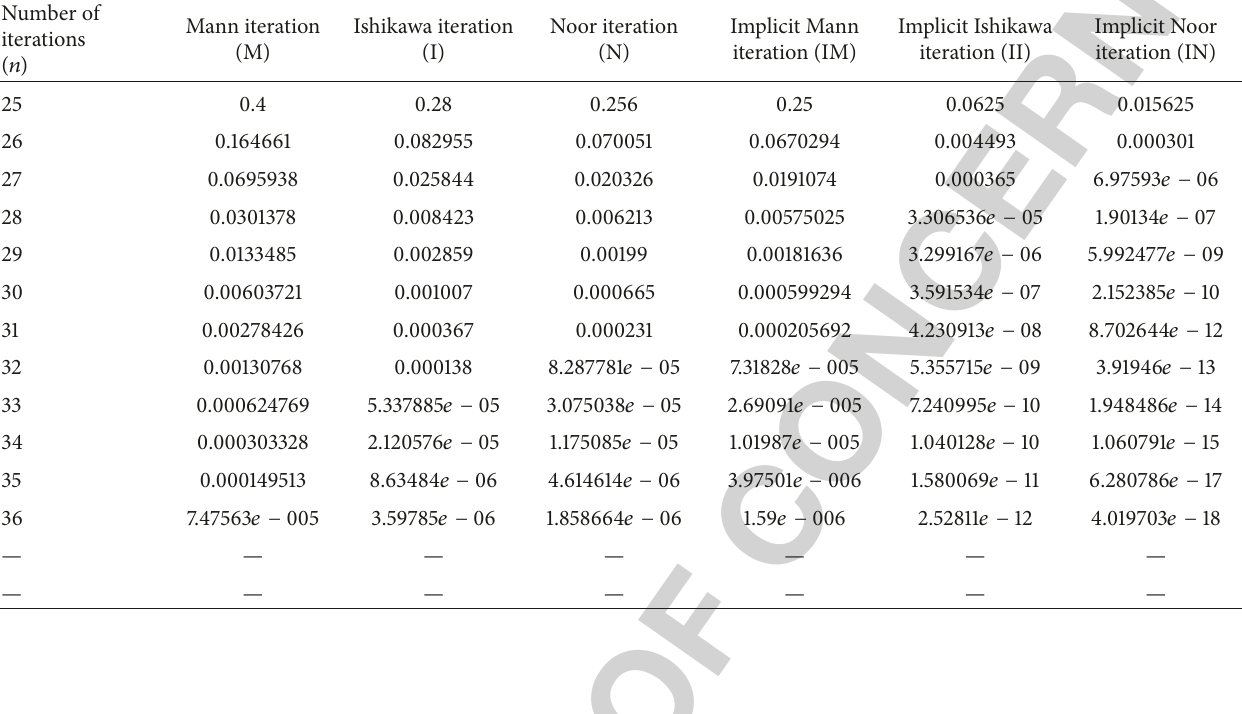
Table 1: Convergence rate comparison of various